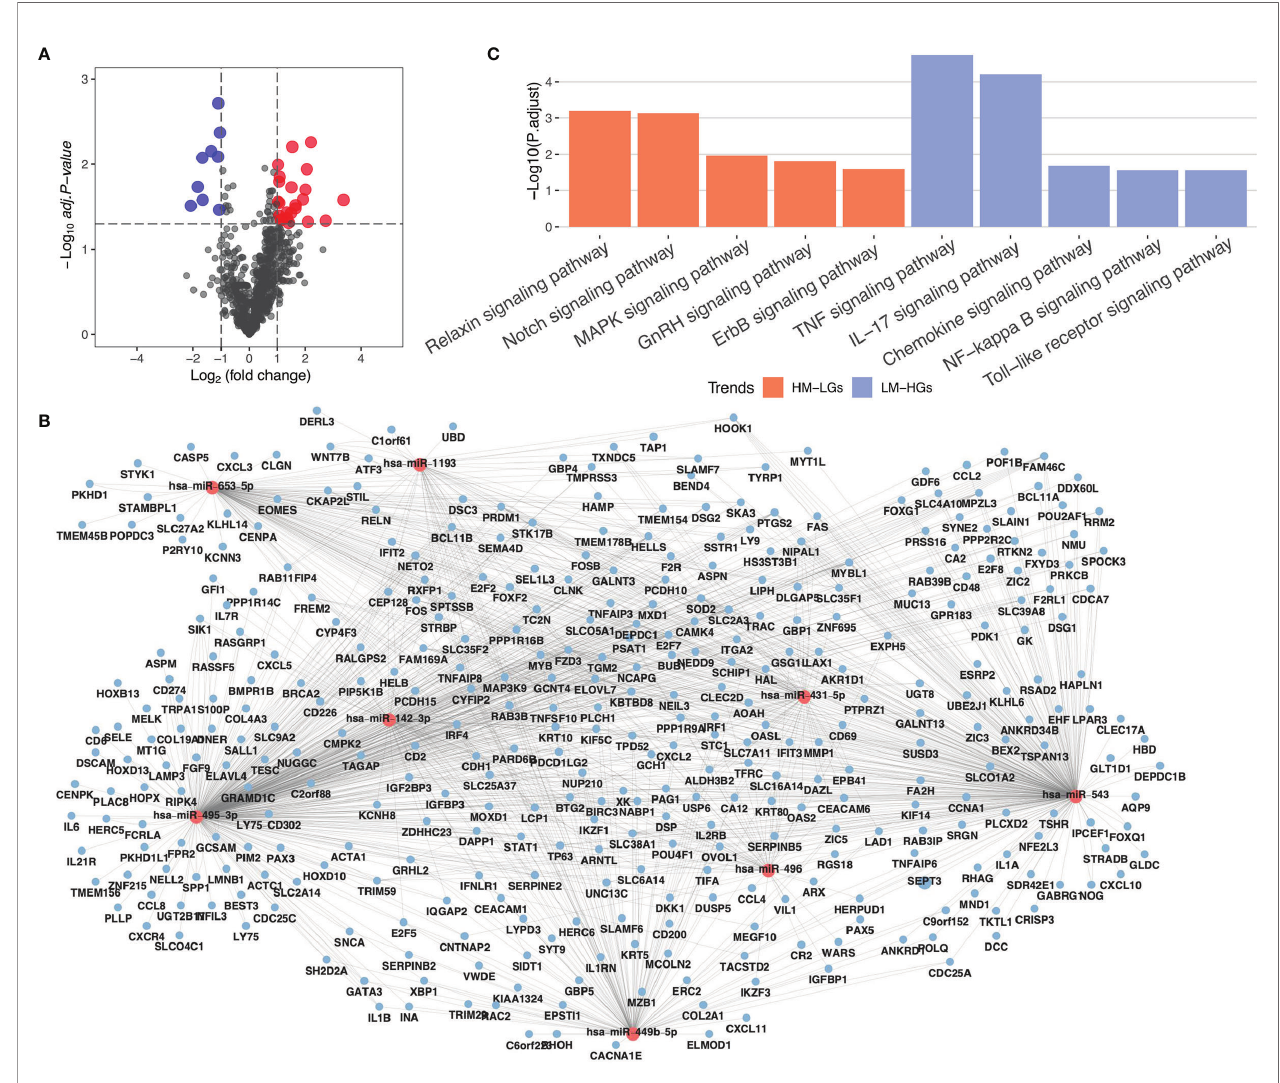
FIGURE 2 | MiRNA regulatory network in RA. (A) Volcano plot for miRNA differential expression analysis. (B) miRNA regulatory network. Red circles represent miRNAs, and blue circles represent mRNAs. (C) KEGG pathway enrichment analysis of highly-expressed miRNAs (HM-LGs) and low-expressed miRNAs